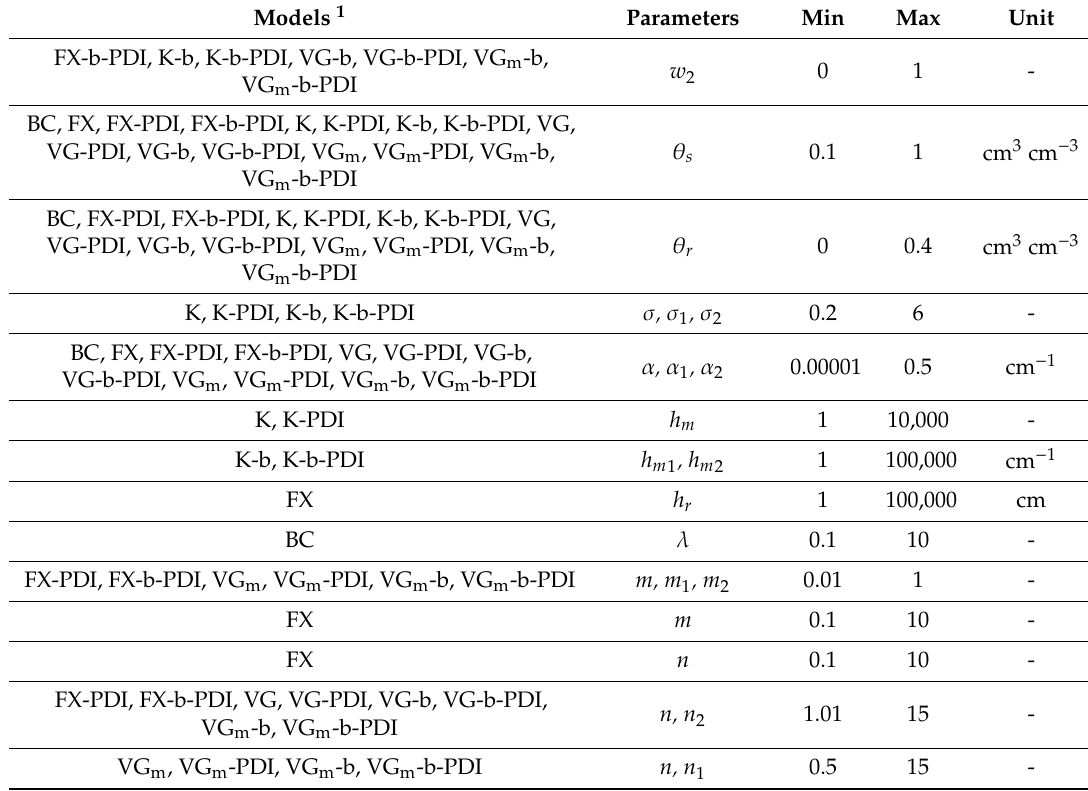
Table 2. Default parameter bounds imposed during the fitting process by the HYPROP-FIT software. Models 1